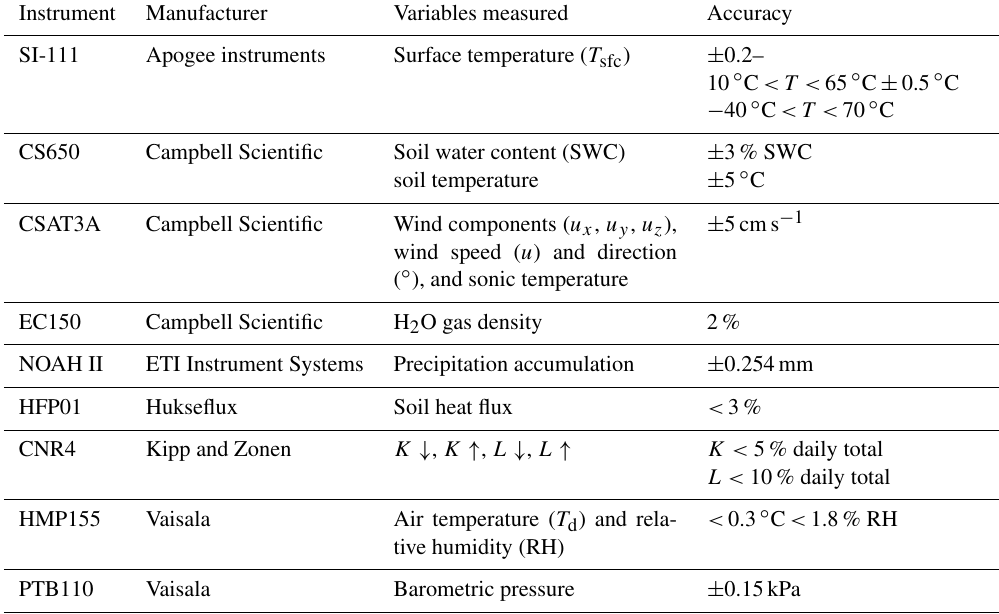
Table 1. Information on instruments used at the Pipers Creek catchment site.